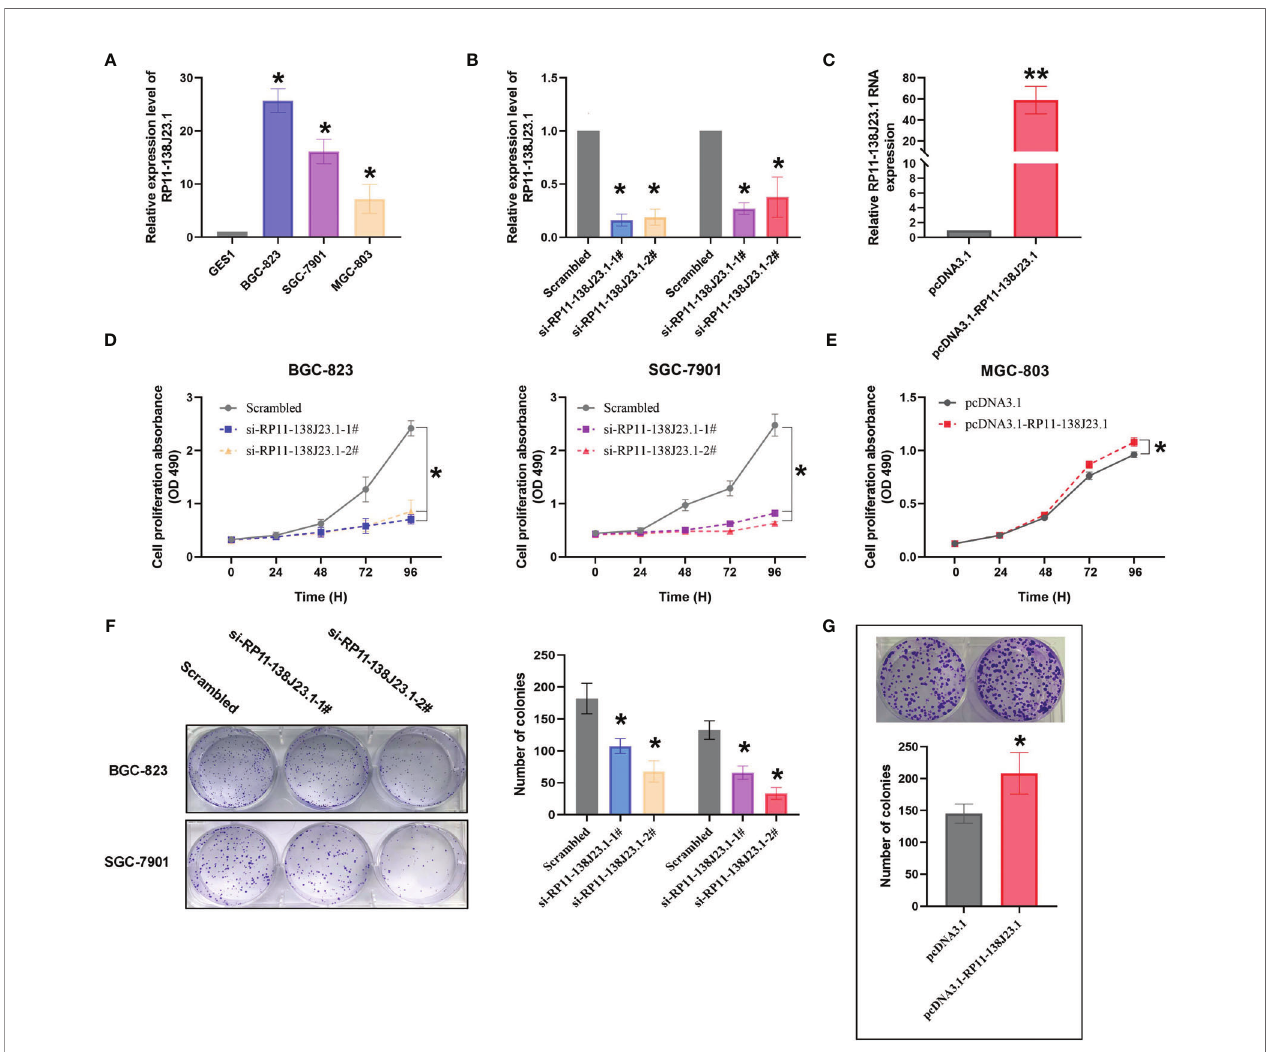
FIGURE 3 | The effects of RP11-138J23.1 on GC cell viability in vitro . (A) qRT-PCR analysis was performed to identify the expression level of RP11-138J23.1 in GC cell lines and human gastric mucosa cell (GES1). The expression levels are normalized to GES1. (B) The RP11-138J23.1 expression level in BGC-823 and SGC-7901 transfect with two discrete chemically synthesized siRNAs. (C) The RP11-138J23.1 expression level in MGC-803 transfected with pcDNA3.1 RP11-138J23.1 and empty vector. (D) MTT assays were used to measure the growth curve of si-RP11-138J23.1-transfected BGC-823 and SGC-7901 cells. (E) MTT assays were used to measure the growth curve of pcDNA3.1 RP11-138J23.1 and empty vector transfected in MGC-803. (F) Colony-forming assays were conducted to determine the proliferation of si-RP11-138J23.1-transfected BGC-823 and SGC-7901 cells. (G) Colony-forming assays were conducted to determine the proliferation of pcDNA3.1 RP11-138J23.1 and empty vector transfected in MGC-803. * p < 0.05; ** p < 0.01. Values indicate the mean ± SD from three independent